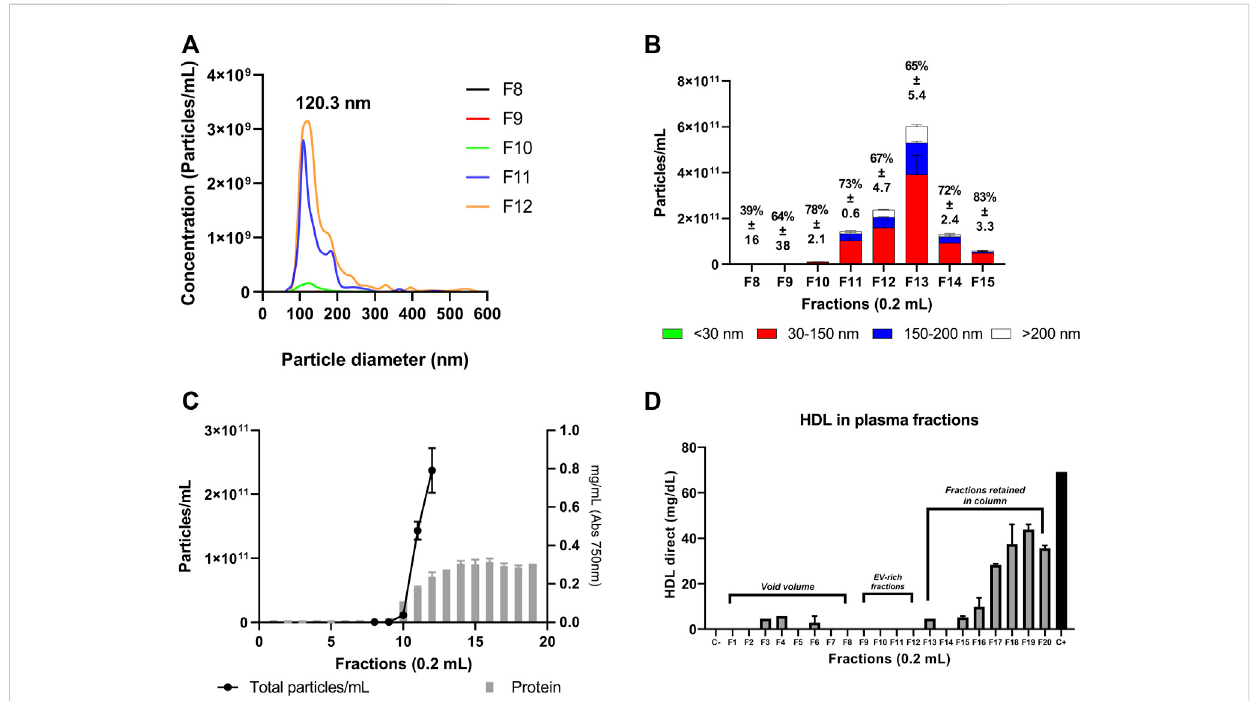
FIGURE 5 Nanoparticle tracking analysis of the plasma fractions. Size distribution curves from the plasma samples were determined by NTA. Each curve representstheaverage ofthreetechnicalreplicatemeasurementsfor eachsmallEVsfraction collected withthecolumnG200/40. (A,B) Particleandsize distributionobtained fromNTAanalysis.Thepercentageovereachcolumnrepresents thefractionofvesicles from30to 150 nm. (C) Particle andprotein content present in the fractions from the G200/40 column. (D) Evaluation of HDL-cholesterol concentration measured by colorimetric assay. C-: HDL-negative control. C+: HDL-positive control (69.1